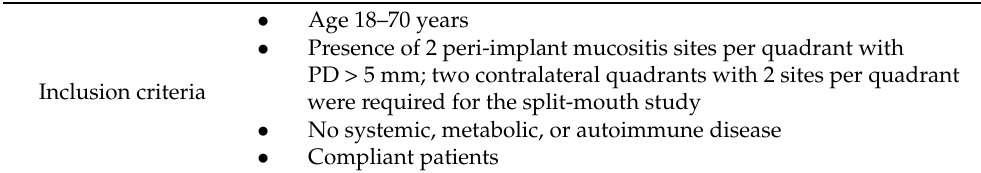
Table 1. Inclusion and exclusion